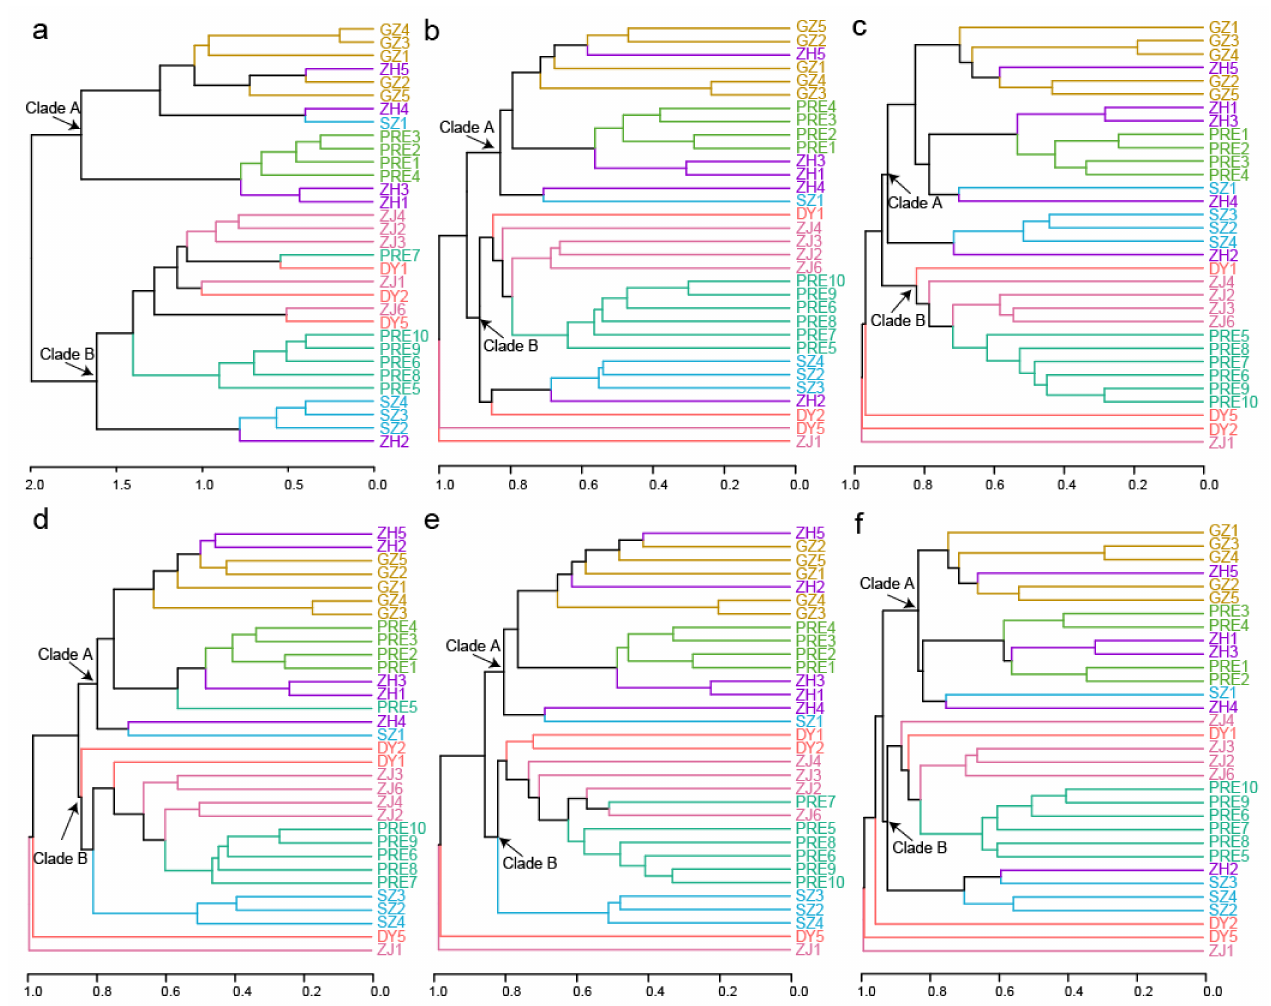
Figure 2. Hierarchical clustering analysis of oligotrich (s.l.) community of 32 samples from six datasets. ( a ) DADA2–100; ( b ) SWARM–100; ( c ) UNOISE–100; ( d ) UPARSE–97; ( e ) UCLUST–97; ( f ) UCLUST–99. Samples from the same sampling area are indicated by the same color except for samples from PRE. Samples named PRE1–4 and PRE5–10 are indicated by different